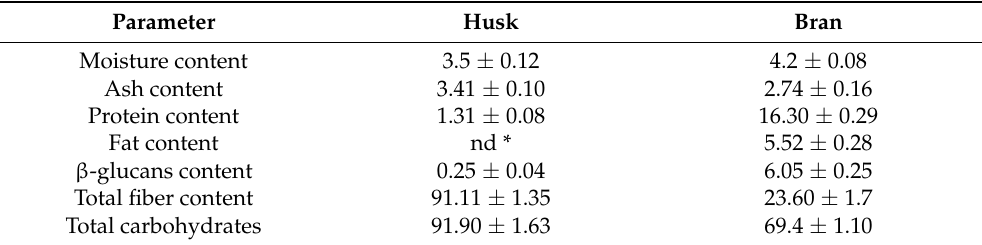
Table 1. Comparison of The Basic Composition of Oat Husk and Bran (g/100 g DW).